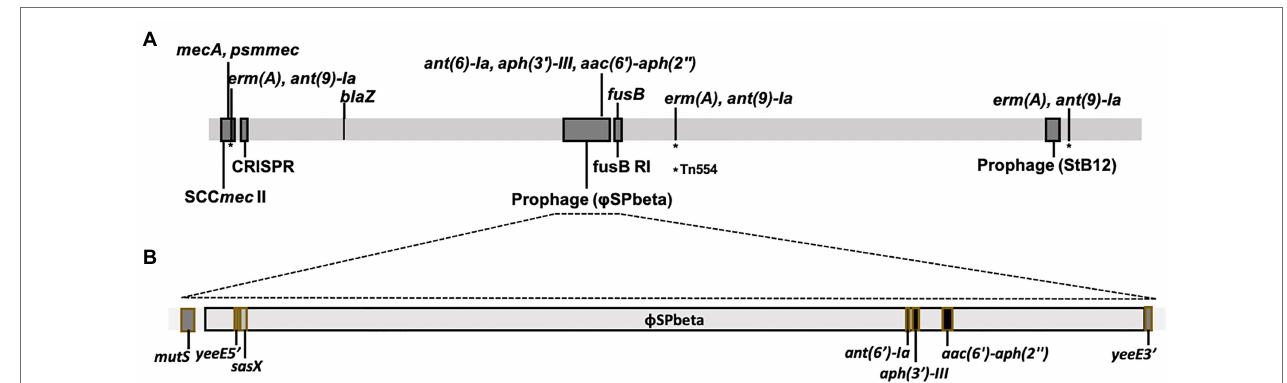
FIGURE 3 | Schematic presentation of genome structure of CGMH-SL118. (A) The linear schematic presentation of the CGMH-SL118 genome; which containing all of the antibiotic resistance genes, MGEs (SCC mec and prophage), and CRISPR. Detailed structure of prophage Spbeta-like was shown in (B) , containing each antibiotic resistance genes and a putative virulence gene. This prophage was inserted in the yeeE (nearby the mutS ), which caused the yeeE separated into two parts on this structure. The asterisk (*) represents the position of